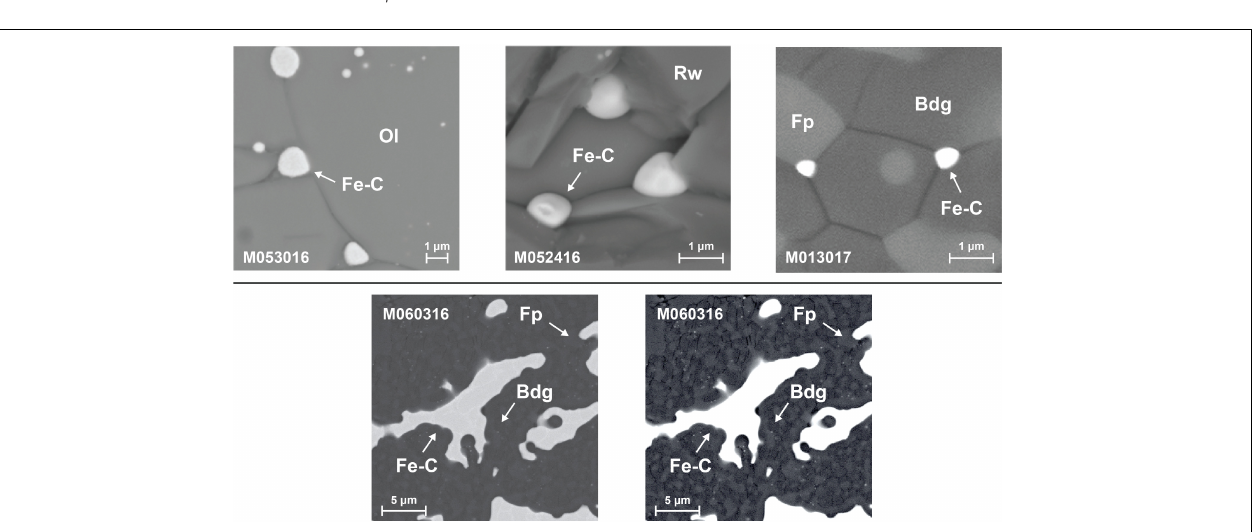
Frontiers in Earth Science |